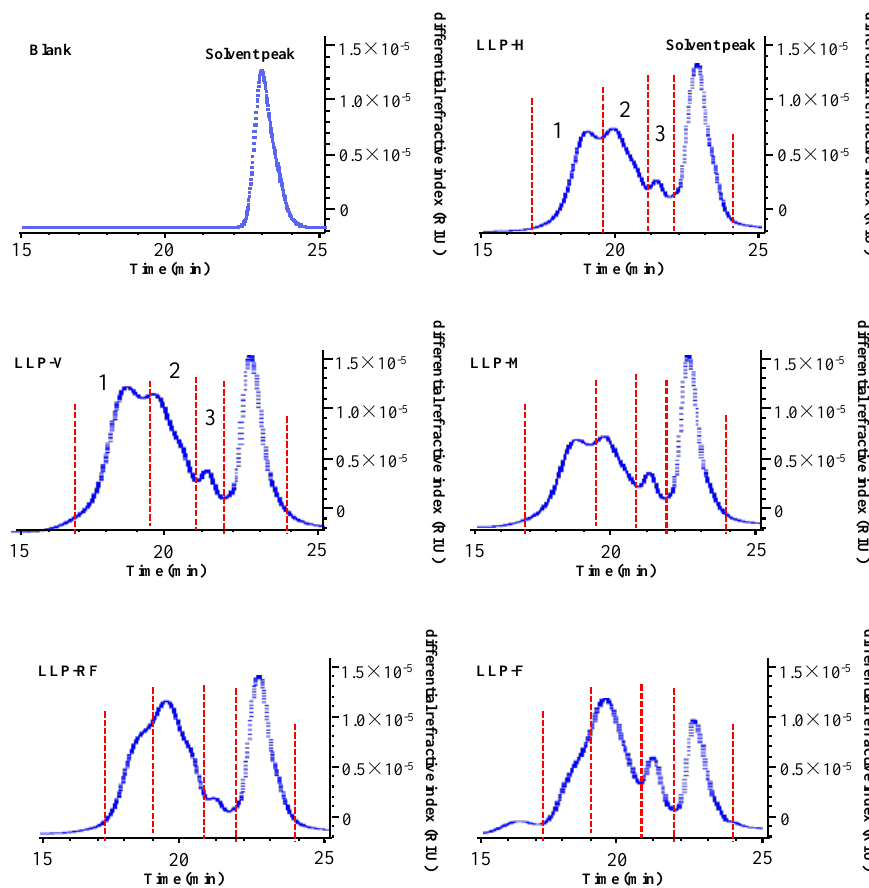
Figure 1. High-performance size-exclusion chromatograms of LLPs.